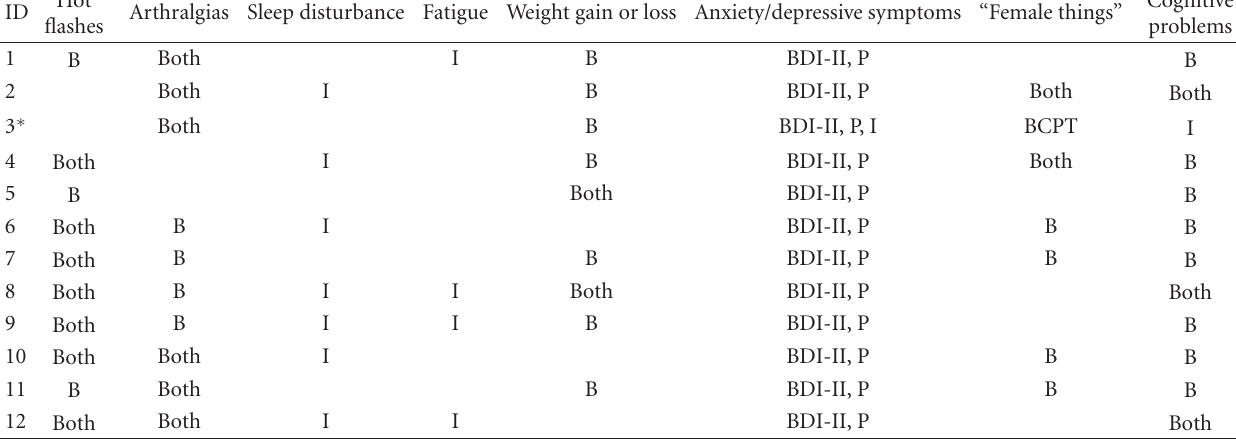
Table 2: The women’s self-reported side e ff